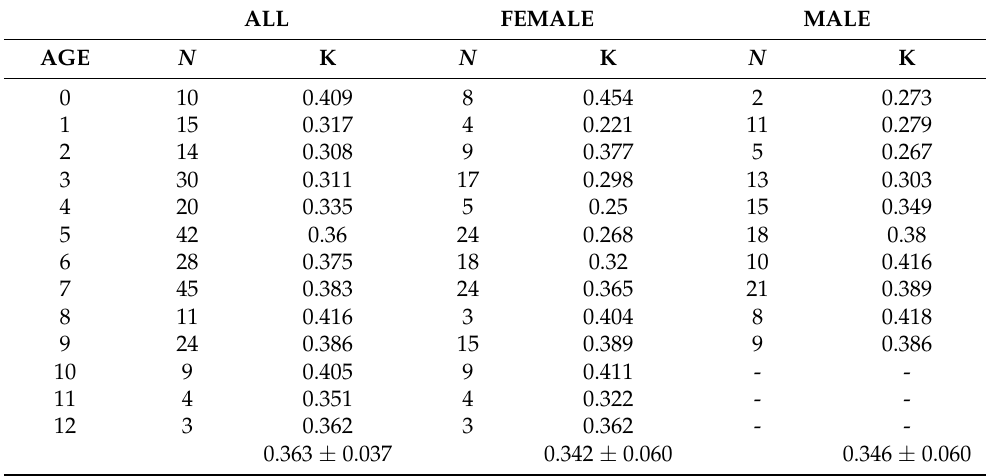
Table 5. The condition factor for Dipturus oxyrinchus inhabiting the Northeastern Mediterranean Sea.